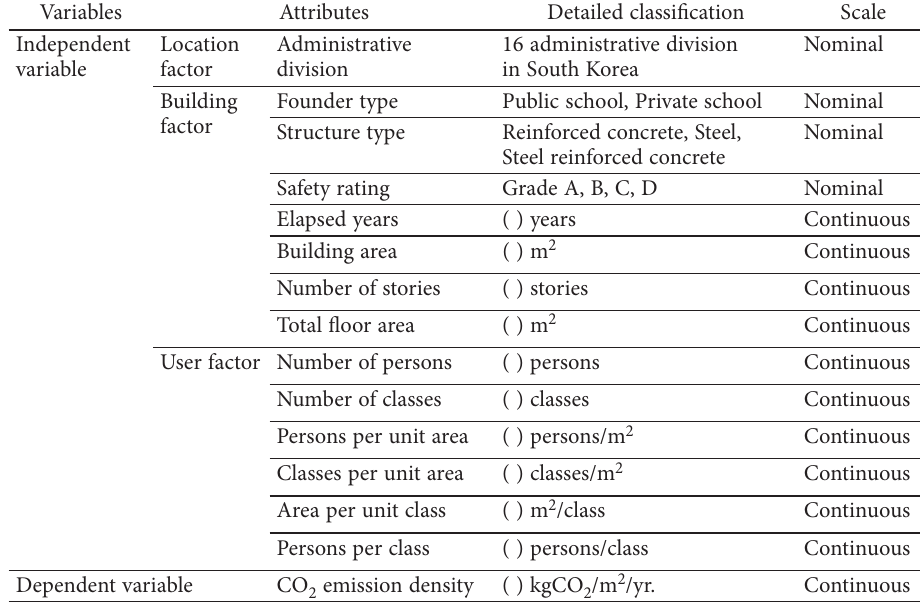
Table 1. Descriptive information on the independent variables and dependent variable